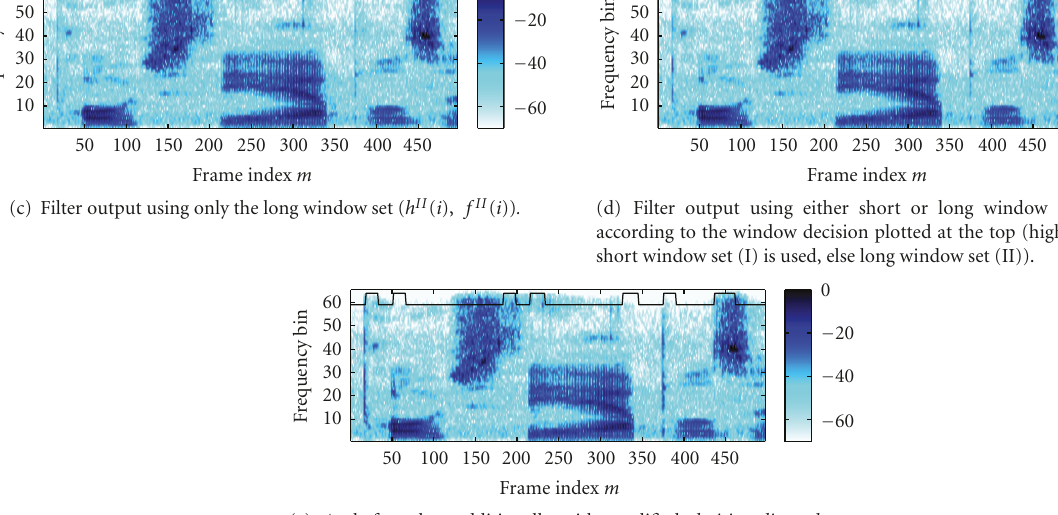
(e) As before, but additionally with modified decision-directed ap- proach. Figure 19: Spectrograms (dB) of input signals and the results obtained after noise reduction with Wiener filter and the methods proposed in Sections 4.1 and 4.2. To create the spectrograms a 128-point DFT with 32 samples frame advance at 16kHz sampling frequency and a Hann data window was